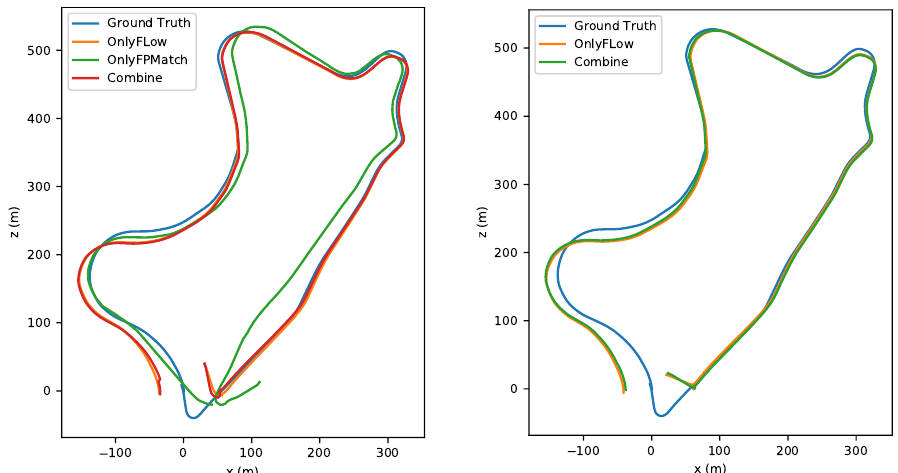
Figure 9. The left image shows the estimated trajectories in a medium-amplitude-motion scene (stride = 3). The right image shows the results from a large-amplitude-motion scene (stride = 4) of sequence 09 in the KITTI dataset